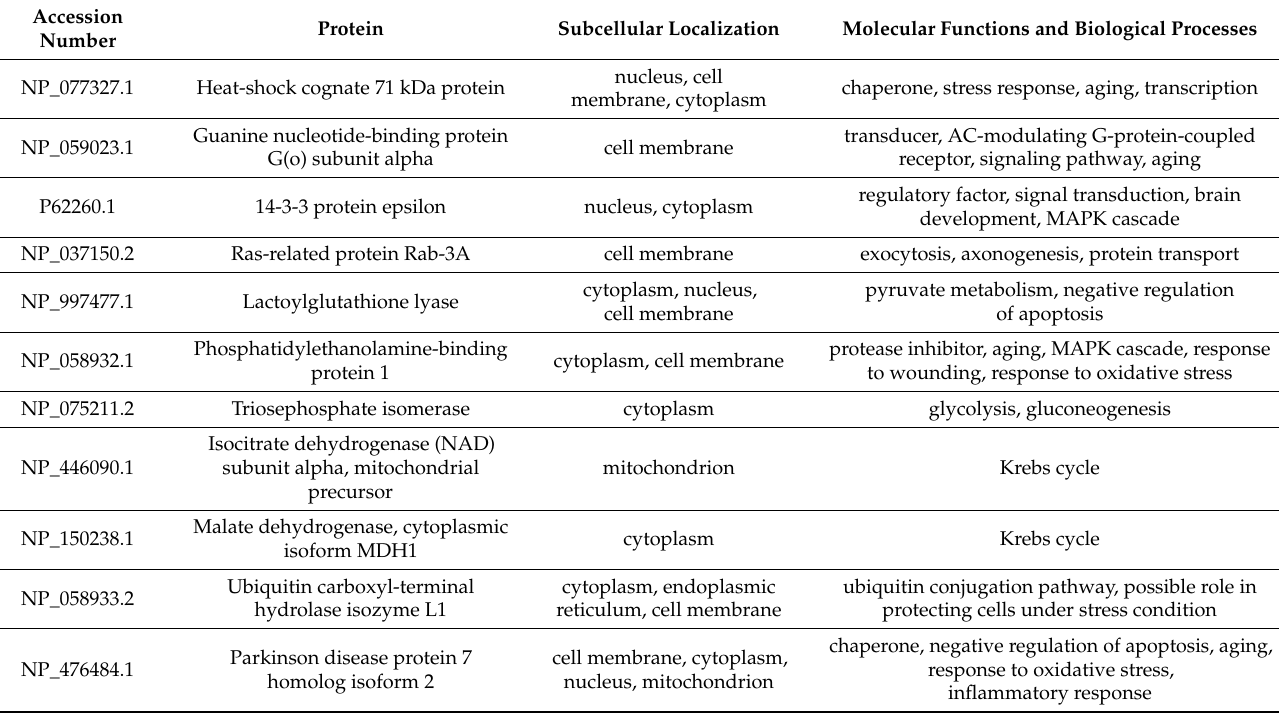
Table 2. Subcellular localization and function of altered proteins identified in mPFC isolated from SNL versus sham-operated rats 2 weeks after the